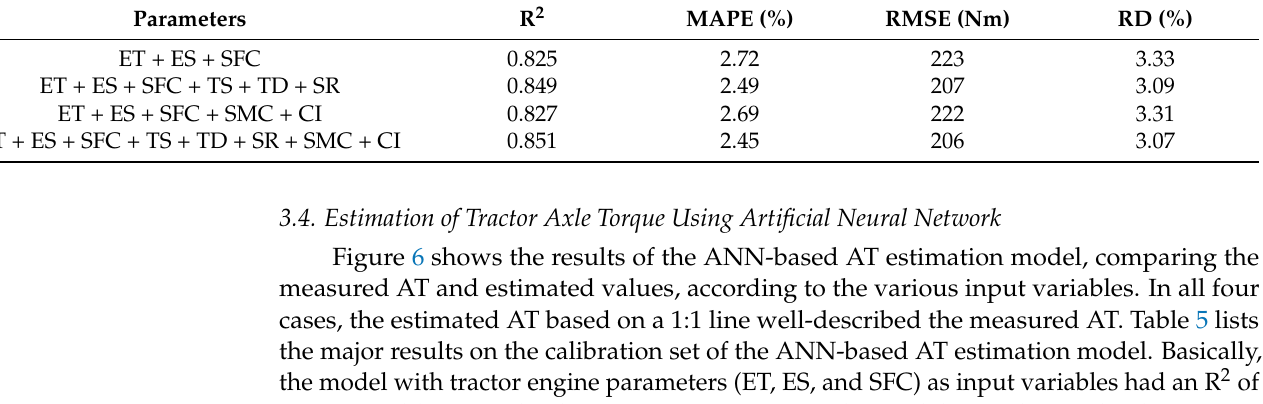
Figure 4. Results of MLR-based axle torque estimation models, comparing estimated values against measured axle torque: ( a ) As a function of the engine parameters; ( b ) as a function of the engine parameters and major tractor parameters; ( c ) as a function of the engine parameters and soil physical properties; and ( d ) as a function of the engine parameters, major tractor parameters, and soil physical properties. Table 3. Performance on the calibration set for MLR-based axle torque estimation models.